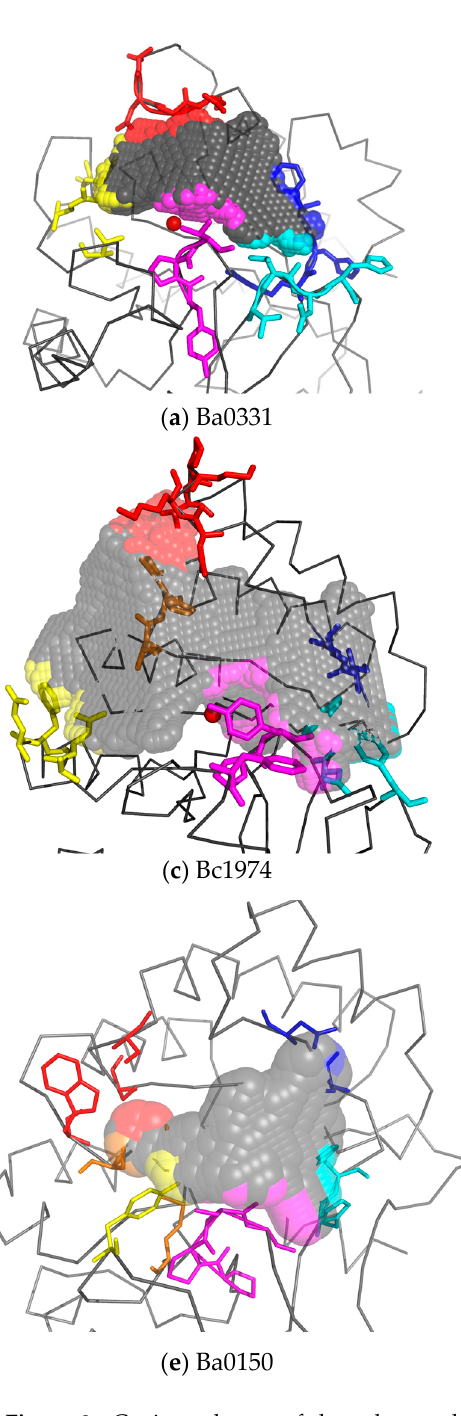
Figure 8. Cavity volumes of the substrate binding grooves of experimentally determined PDAs. The volume of the cavity extending on each side of the zinc ion is represented with grey spheres. The domains that set the outer boundaries of the binding groove are coloured in blue, cyan, magenta, yellow, orange, or red in accordance with Figure 4 and their corresponding amino acid residues are shown in sticks. Where applicable, the zinc ion is represented as red balls. Despite the overall similar fold of all NodB domains, the relative analysis revealed profound variation between the Fn3-containing PDAs Ba0331 ( a ) and Ba0330 ( b ) as well as between the highly homologous Bc1974 ( c ) and Bc1960 ( d ). The non-metal containing Ba0150 ( e ) has a rather small and deep crevice, while the cavity of the putative MurNAc deacetylase Ba0424 ( f ) contains a restriction ring at the post-MT1 region (coloured orange).